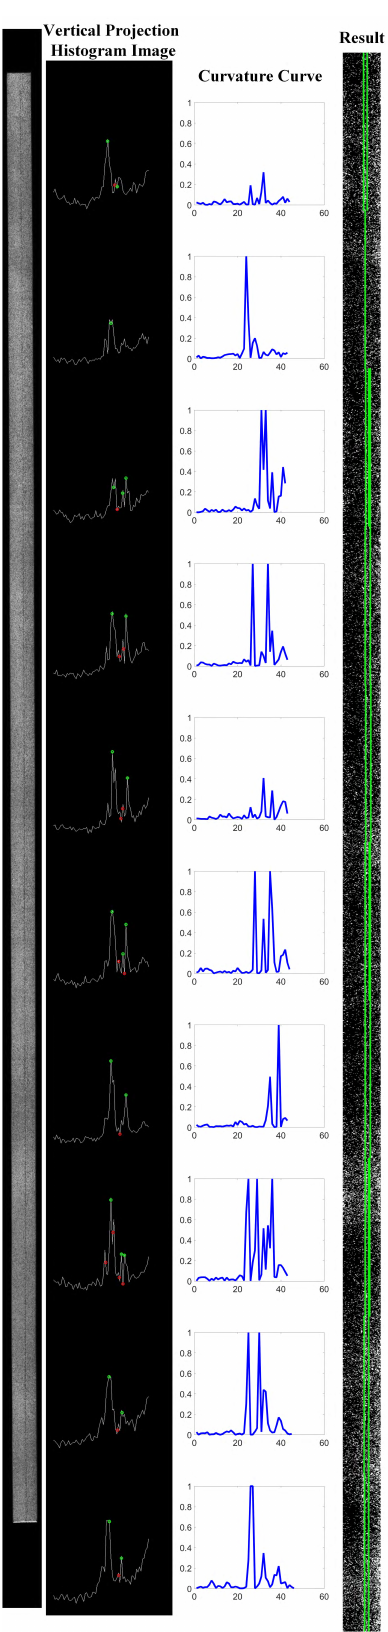
Figure 12 Figure 12. Result 1. The green circles represent local maximums, red circles represent local valleys, and the green lines represent the detected